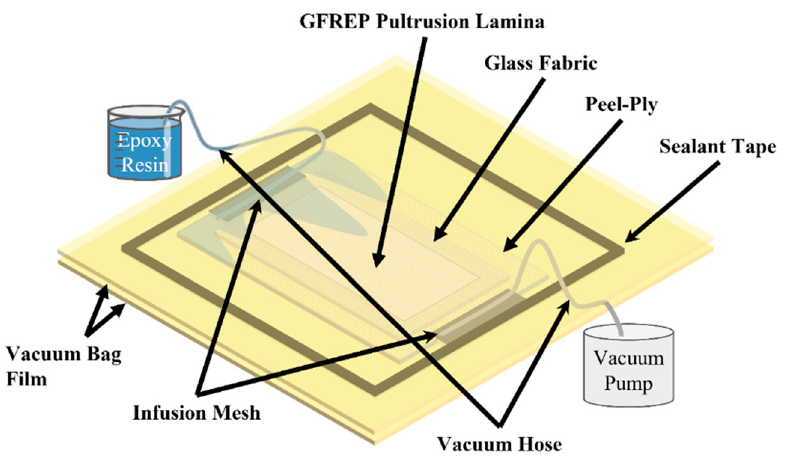
Figure 4. Vacuum ‐ assisted resin infusion diagram. Figure 4. Vacuum-assisted resin infusion